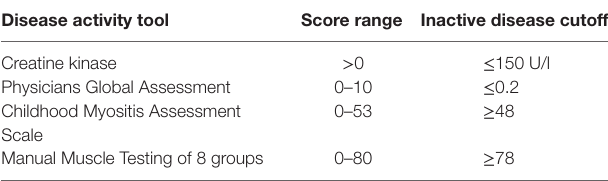
TaBle 3 | Measures of disease activity. Disease activity tool